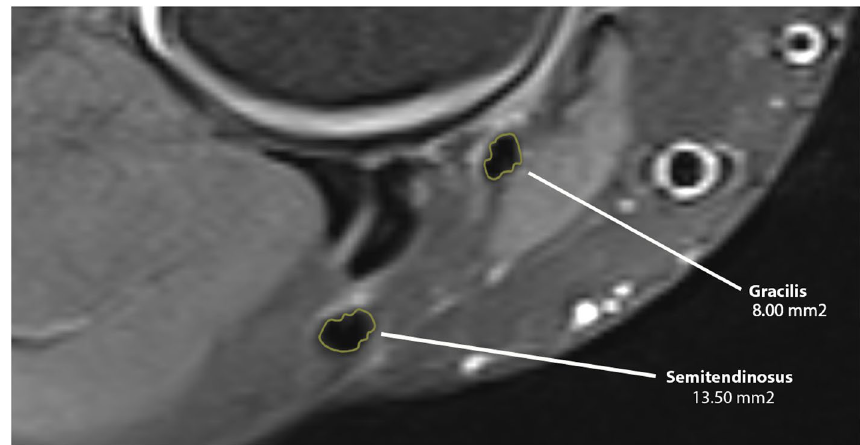
Fig. 2 The CSA measurement for semitendinosus and gracilis was performed at 2 x